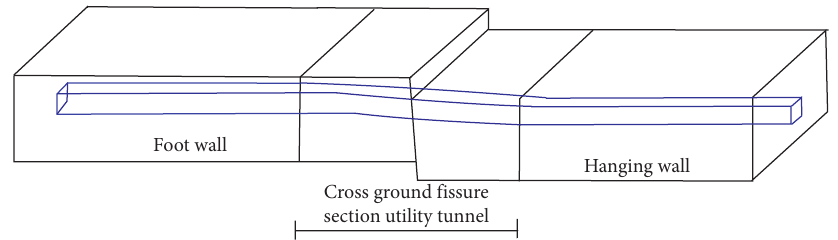
Figure 6: Sinking model of the utility tunnel crossing ground fissure